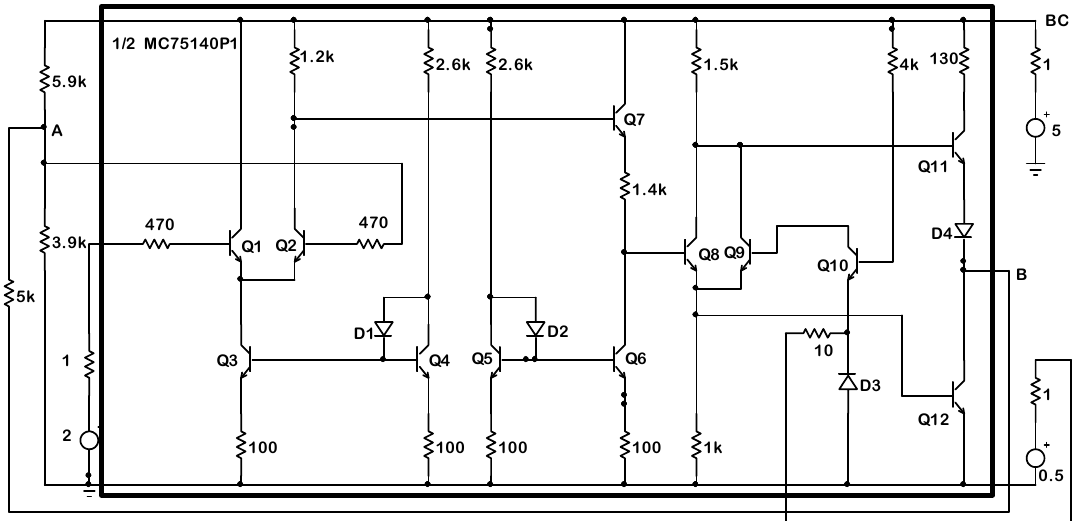
Figure 6. A circuit based on the MC75140 possessing three DC